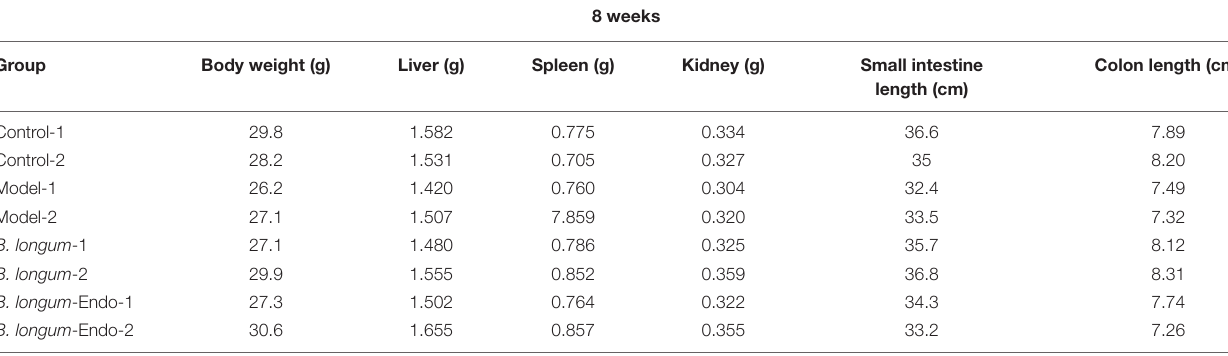
TABLE 3 | Organ parameter changes in mice at 12 weeks after AOM injection.